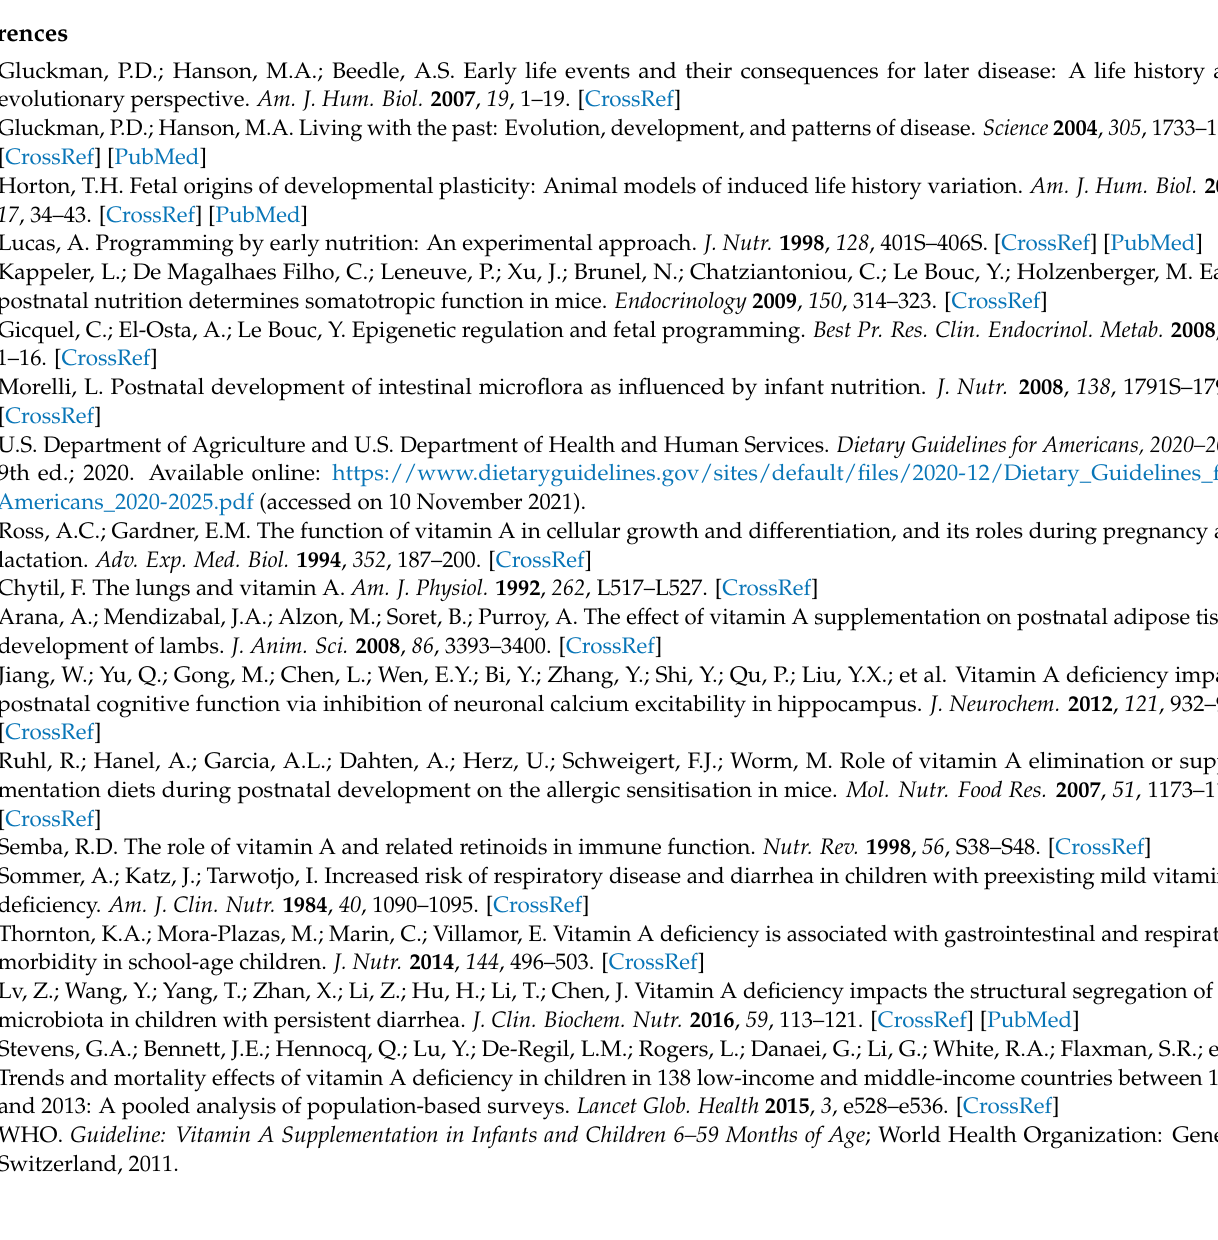
Figure S2: Fraction of ingested dose existing in retinol in different segments of intestine vs. time after administration of 3 H-labeled VA supplement in neonatal